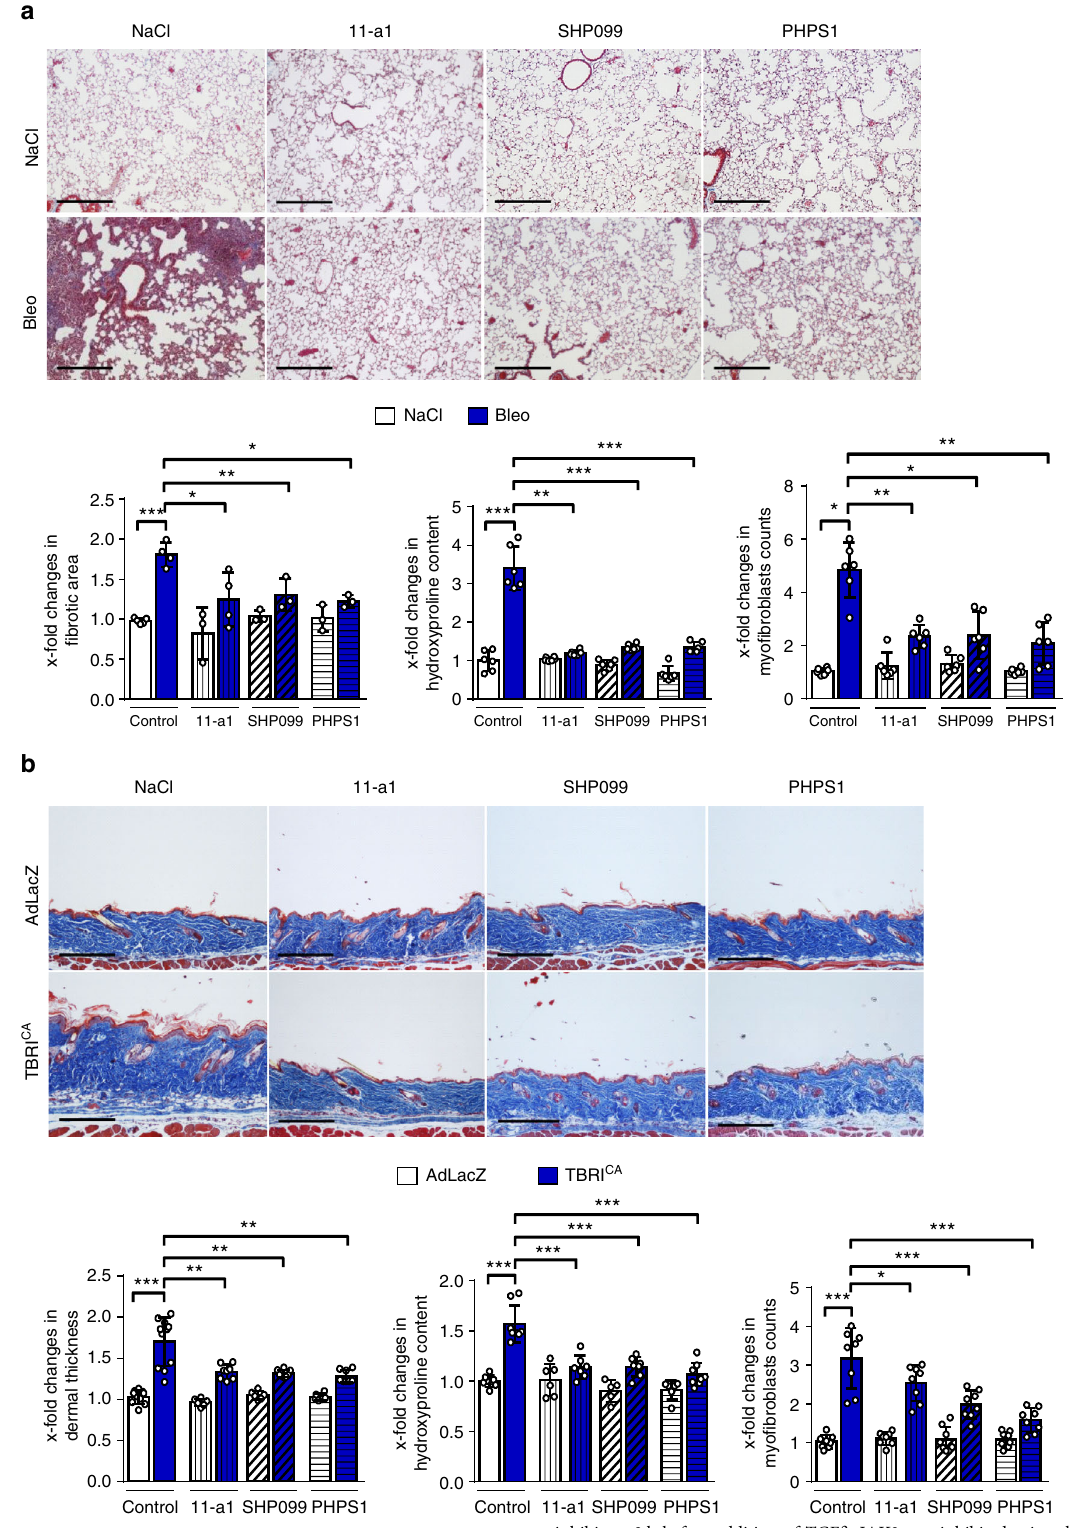
(forward), 5 ′ -UAG AGG AAG UCG AUG UAC C-3 ′ (reverse); non-targeting siRNAs (Life Technologies, Darmstadt, Germany) served as controls. Cre-mediated recombination in murine fi broblasts isolated from Shp2 fl / fl mice was induced by infection with type 5 adenoviral vectors encoding for Cre recombinase (AdCre - 80 IFUs/ fi broblast). Type 5 adenoviral vectors encoding for LacZ (AdLacZ) served as controls. In selective experiments, cells were incubated with recombinant TGF β (10 ng/ml) (PeproTech, Hamburg, Germany). SHP2 activity was inhibited in fi broblasts using the following inhibitors: NSC- 87877 (100µM), SHP099 (1.4 µM) and 11-a1 (0.2µM). Cells were pretreated with